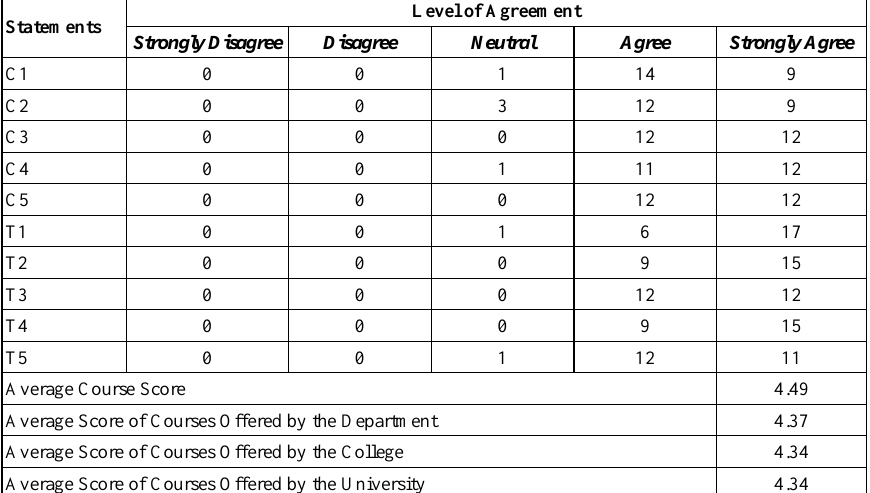
Table 6. Course evaluation for Data Processing and Analysis